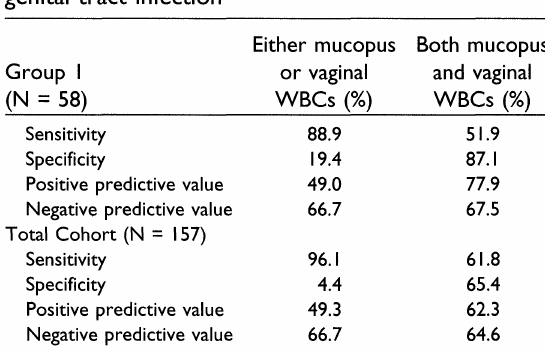
aSome data missing; percent based on known data. TABLE 2. Sensitivity, specificity, and predictive values of mucopurulent cervicitis and presence of vaginal white blood cells for predicting upper genital-tract